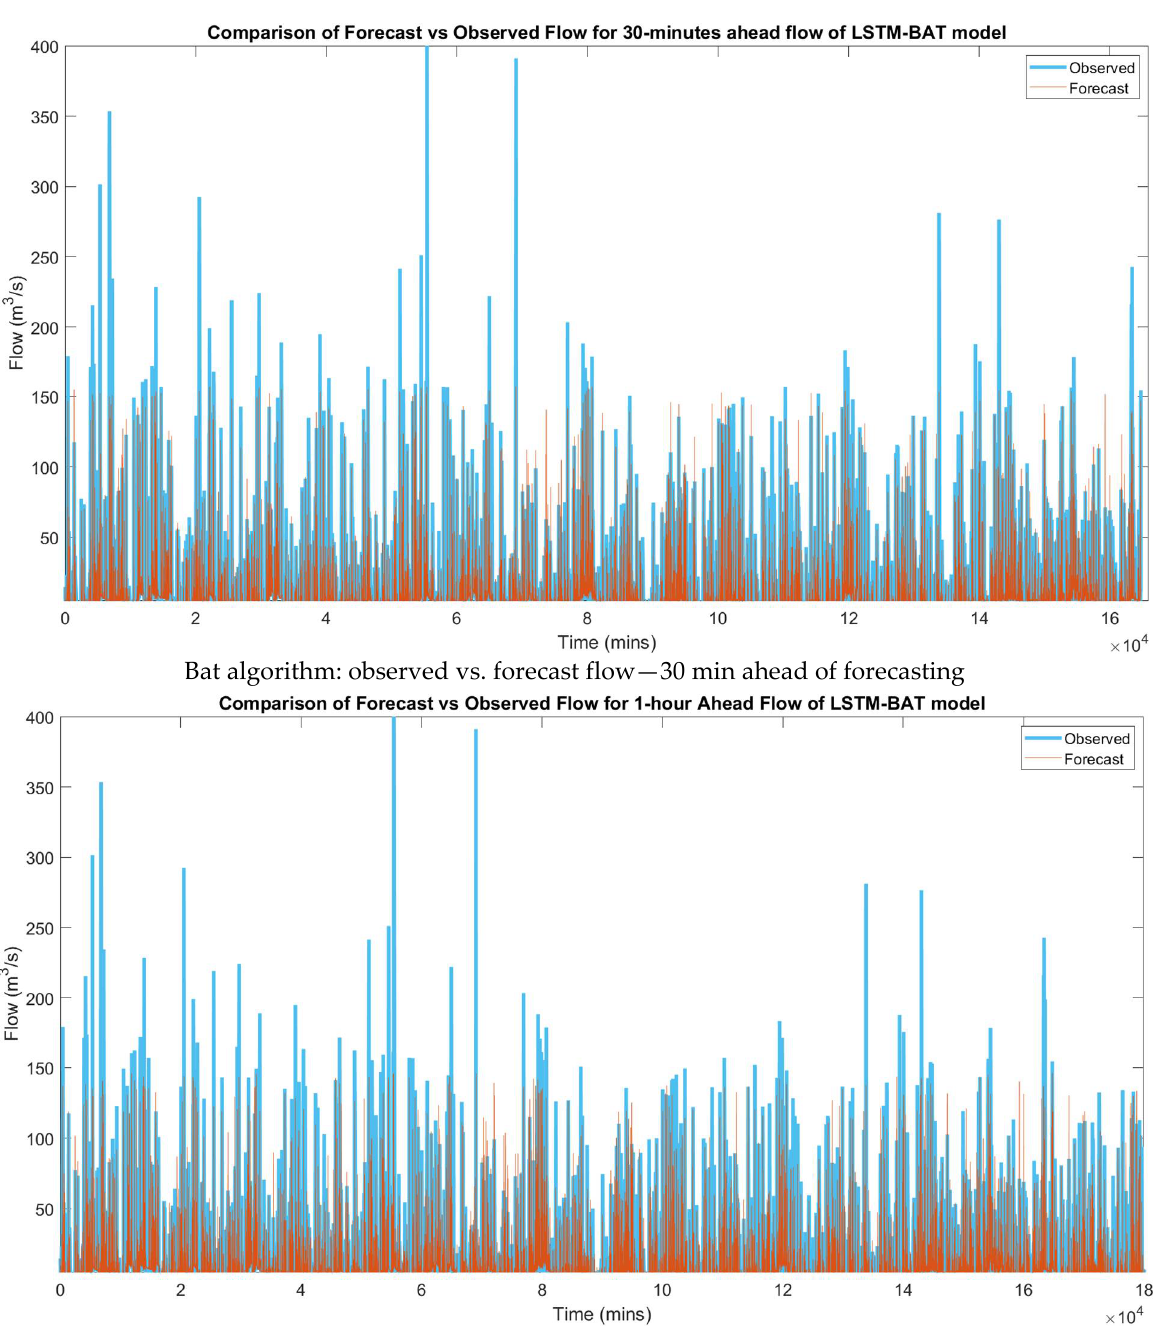
Bat algorithm: observed vs. forecast flow—1 h ahead of